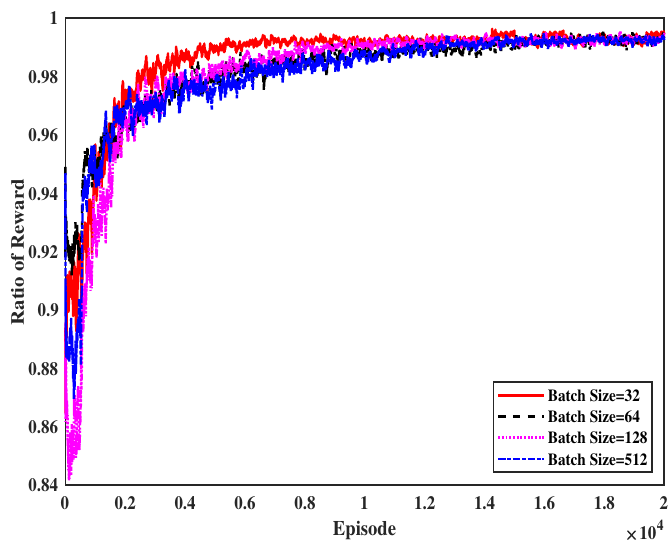
Figure 6. Convergence of performance over different number of batch